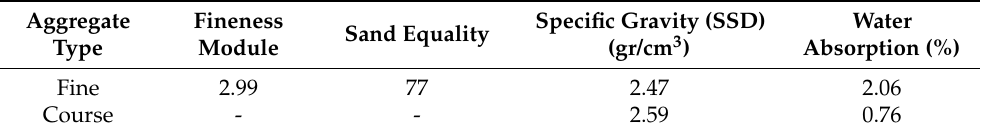
Table 2. Aggregates physical